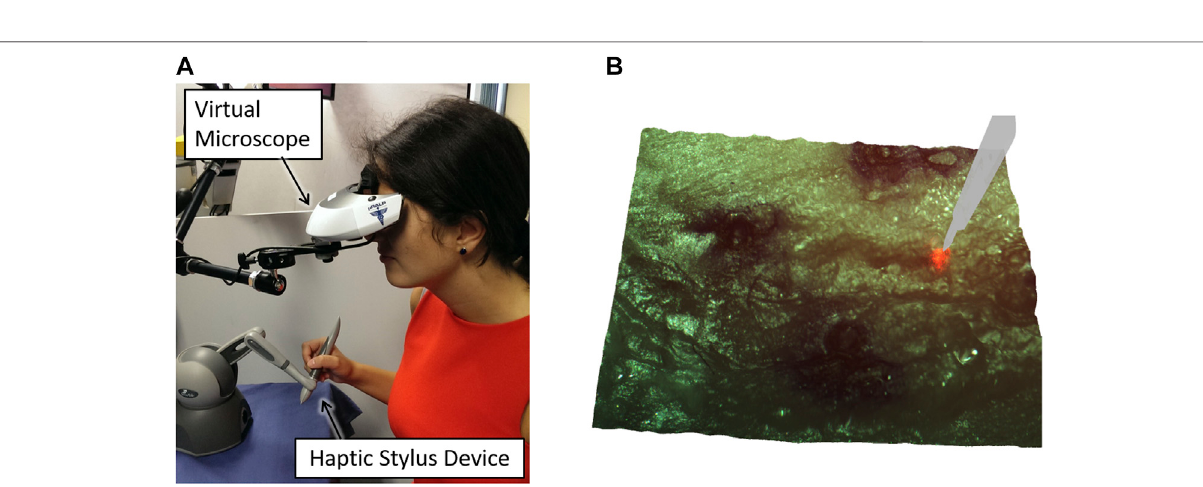
Frontiers in Robotics and AI |